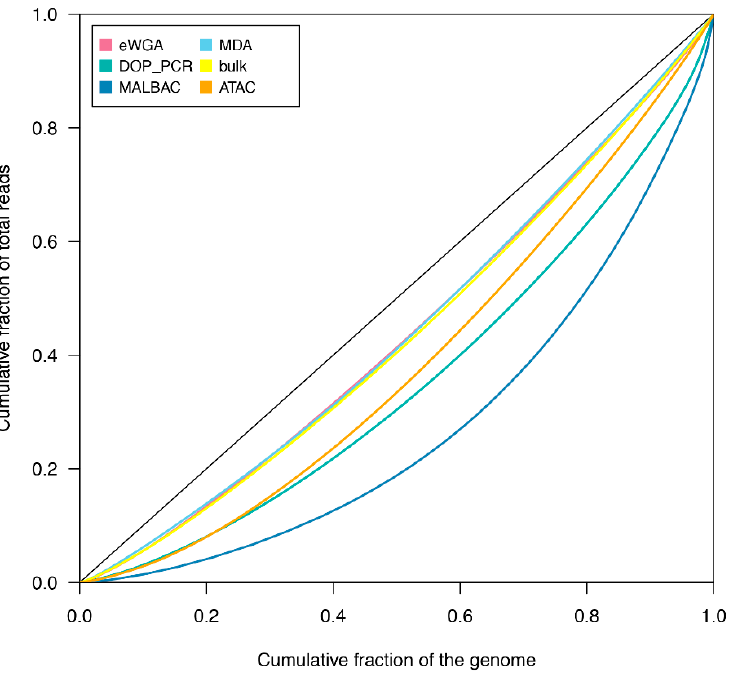
Figure 2. Lorenz curves of coverage uniformity for reconstructed mtDNA genomes. The cumulative fraction of sequence reads against the cumulative fraction of genome covered is shown for each amplification protocol (eWGA, DOP-PCR, MALBAC and MDA) followed by WGS in HT-29 cells, the unamplified bulk of HT-29 and scATACseq data. The diagonal line represents the ideal perfect uniform coverage. The plot was generated using the Lc function in R package ineq .